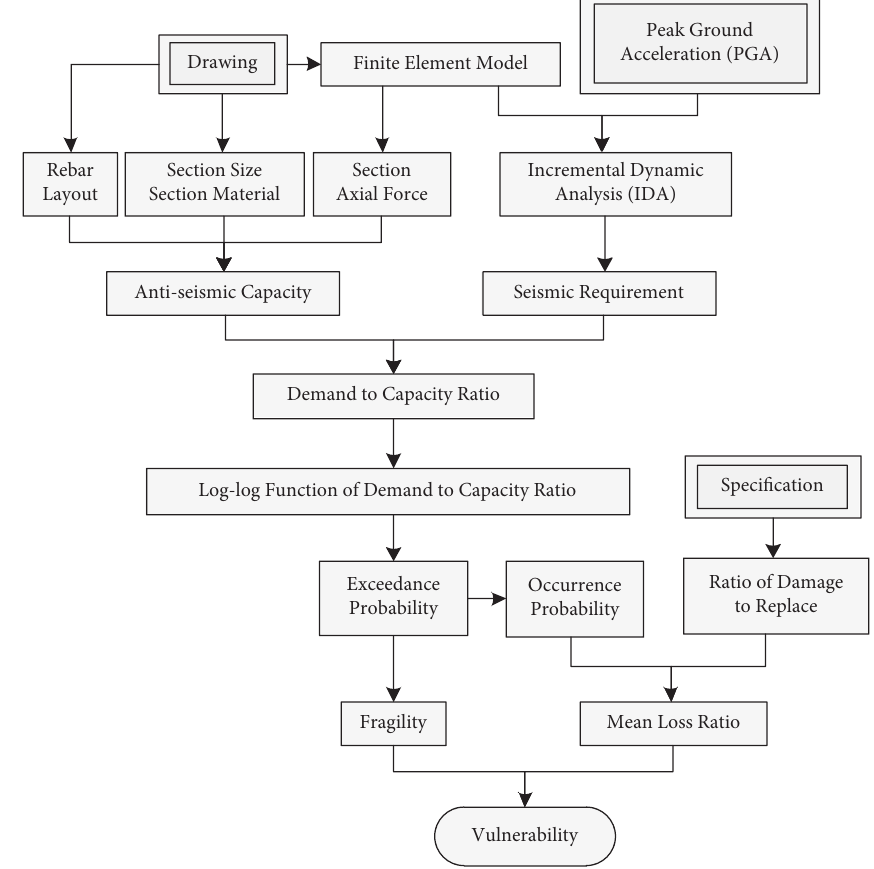
Figure 1: Flow chart of the vulnerability evaluation method.